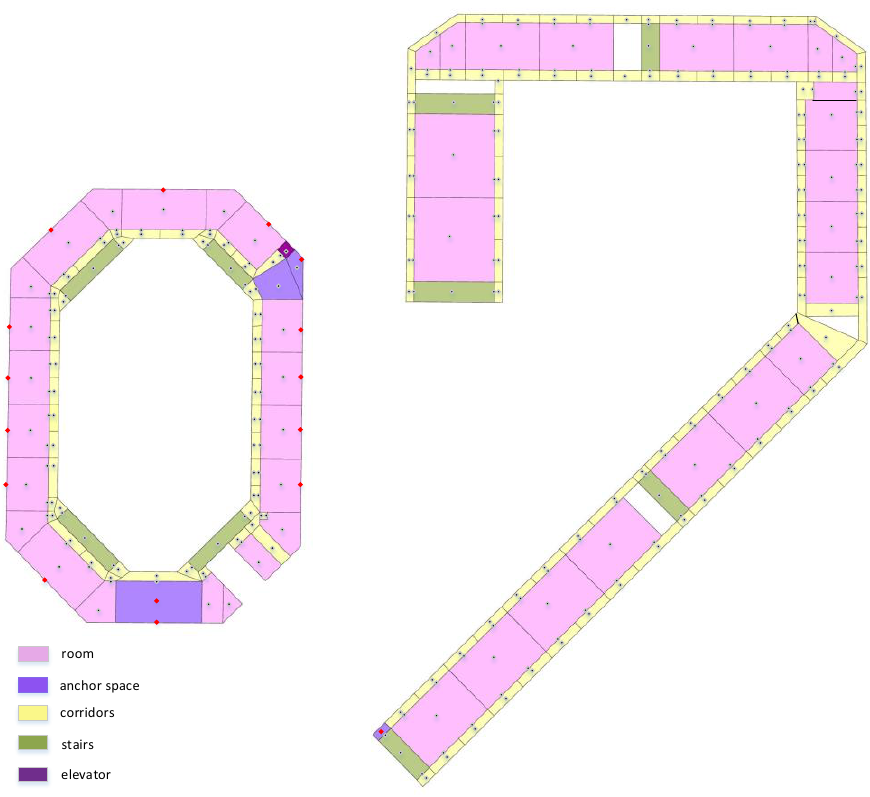
Figure 6. A navigation grids diagram of single-layer indoor space.